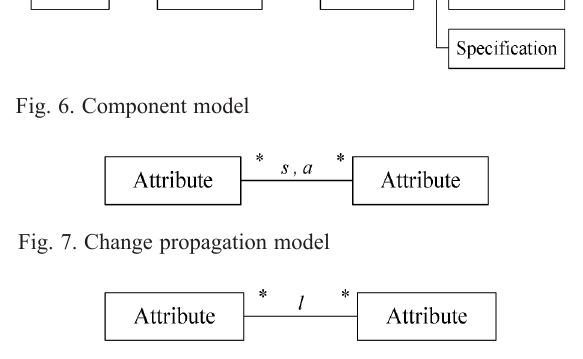
Fig. 8. Change prediction model